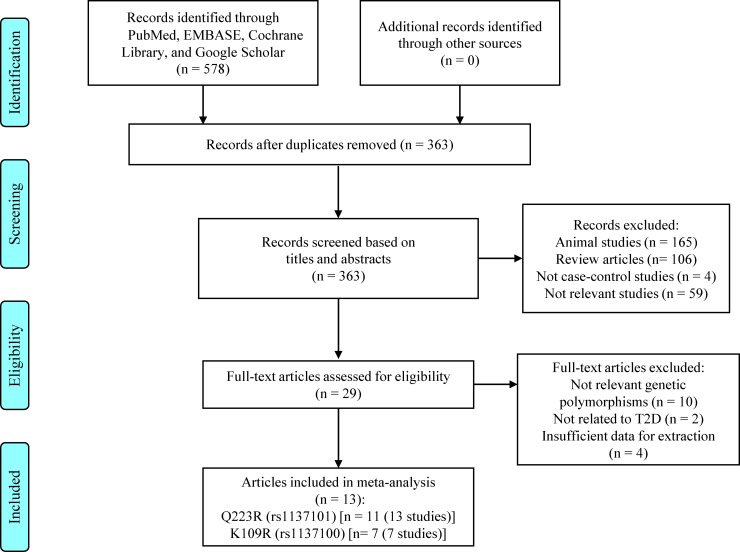
A PRISMA flow diagram depicting the literature search and study selection process.Abbreviations: EMBASE, Excerpta Medica Database; T2D, type 2 diabetes.